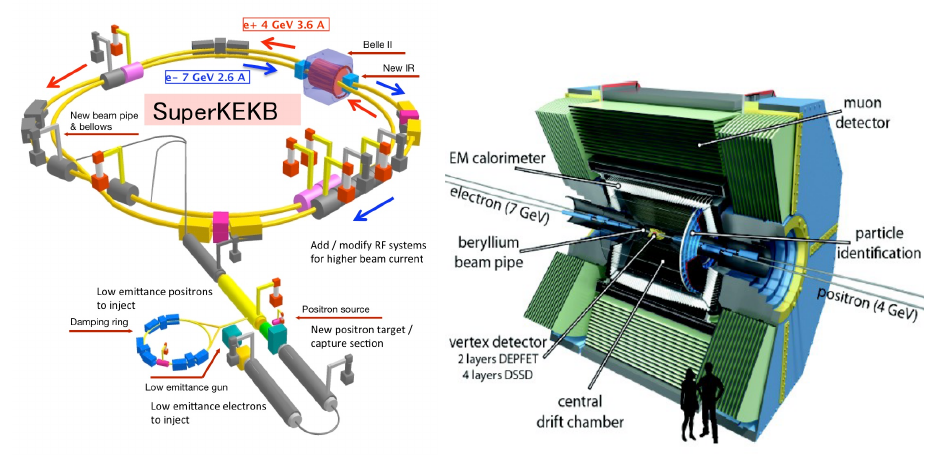
Figure 1: Schematic representation of the SuperKEKB rings (left) and the Belle II detector (right).